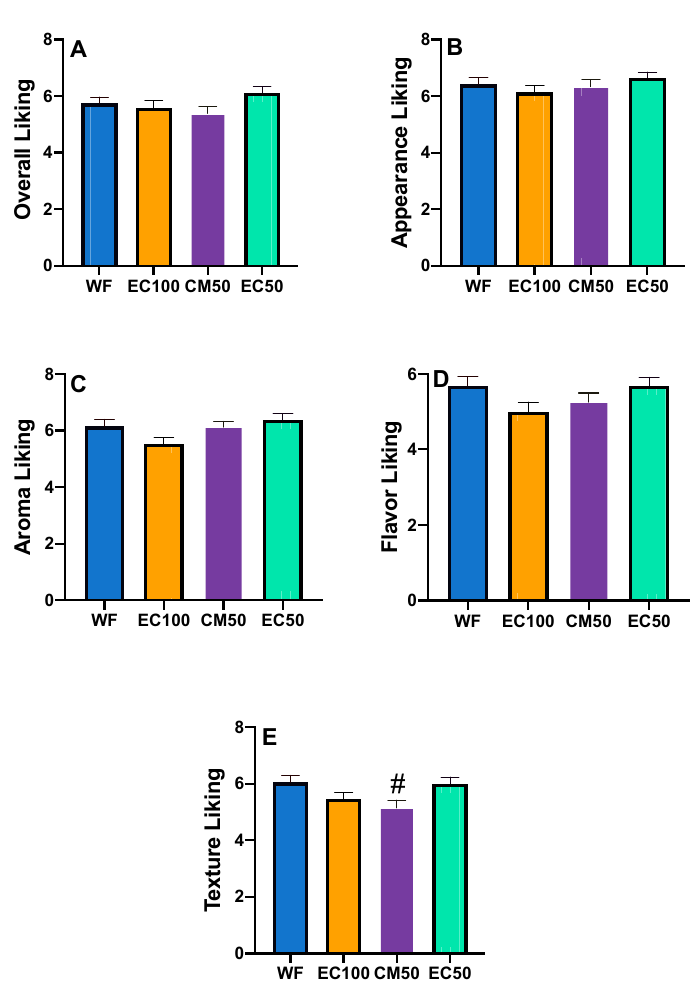
Figure 4. Hedonic scores (means ± S.E.) of whole wheat flour (WF) roti (Indian flat bread) samples fortified with encapsulated defatted Nannochloropsis oceanica (EC) and color-masked defatted Nan- nochloropsis oceanica (CM) day 0 on ( A ) Overall liking; ( B ) Appearance liking; ( C ) Aroma liking; ( D ) Flavor liking; and ( E ) Texture liking. # p = 0.06, n = 58.